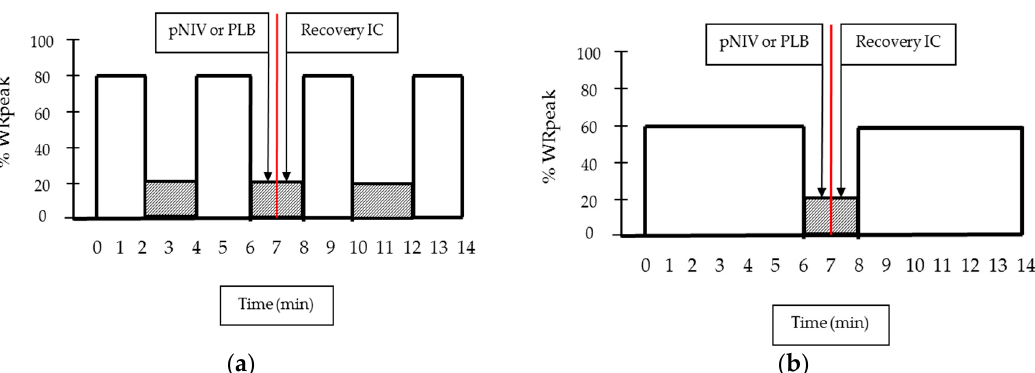
Figure 2. Exercise protocols: ( a ) High-intensity 2-min intermittent exercise protocol and ( b ) moderate-intensity 6-min intermittent exercise protocol. Within these two protocols (HI or MOD), each patient performed two more visits / exercise tests using pNIV and PLB during recovery from exercise in balanced order. Typical examples of high- and moderate-intensity exercise bouts are shown by open squares and recovery periods by shadowed squares.